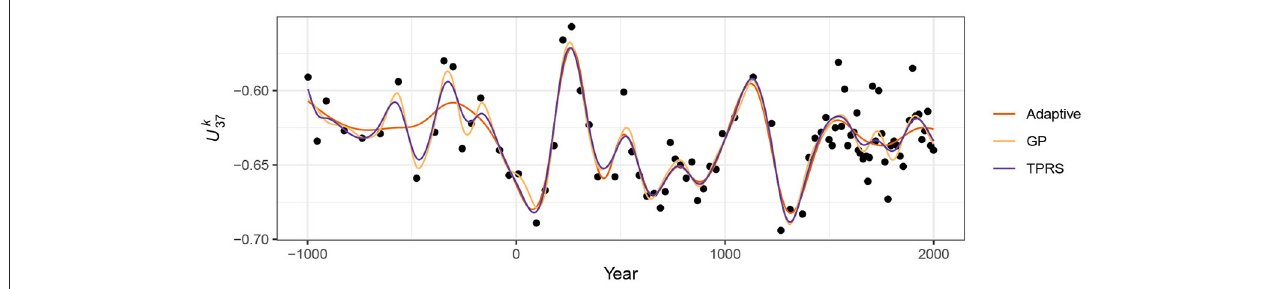
FIGURE 14 | Comparison of trends estimated using (i) adaptive smooth, (ii) Gaussian process, and (iii) thin plate regression spline bases for the U K 37 time